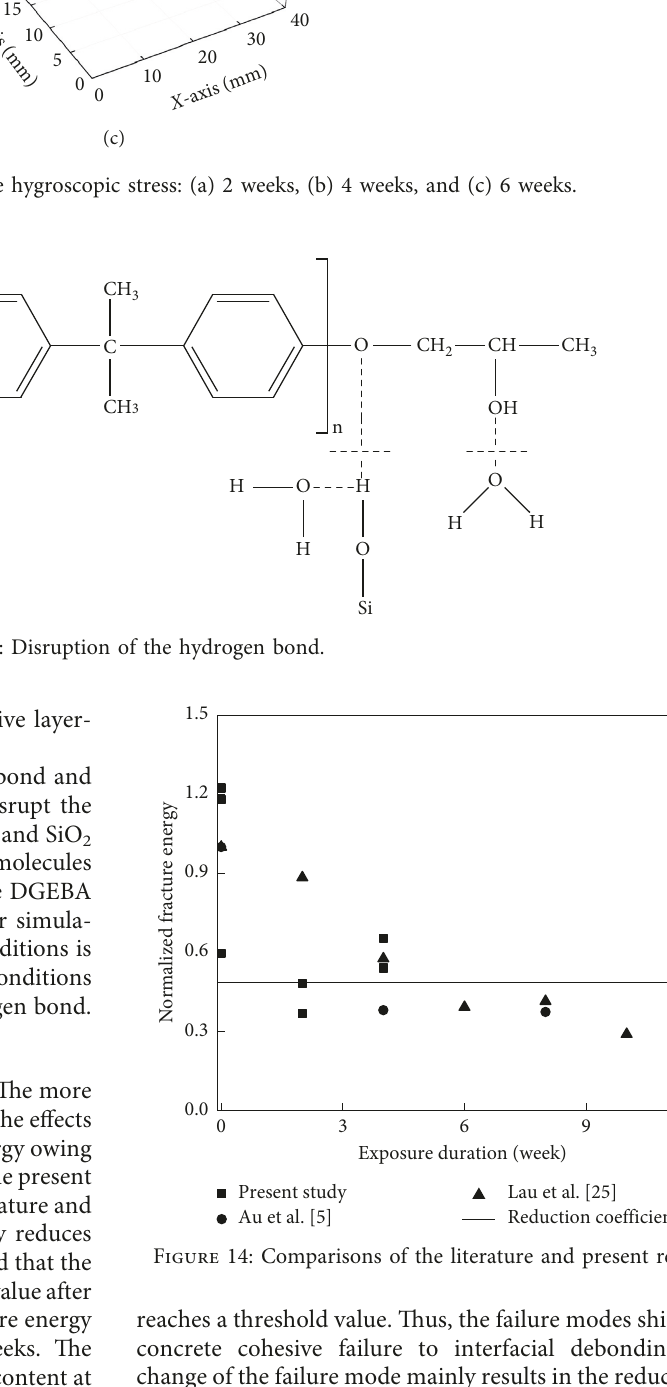
Figure 14: Comparisons of the literature and present